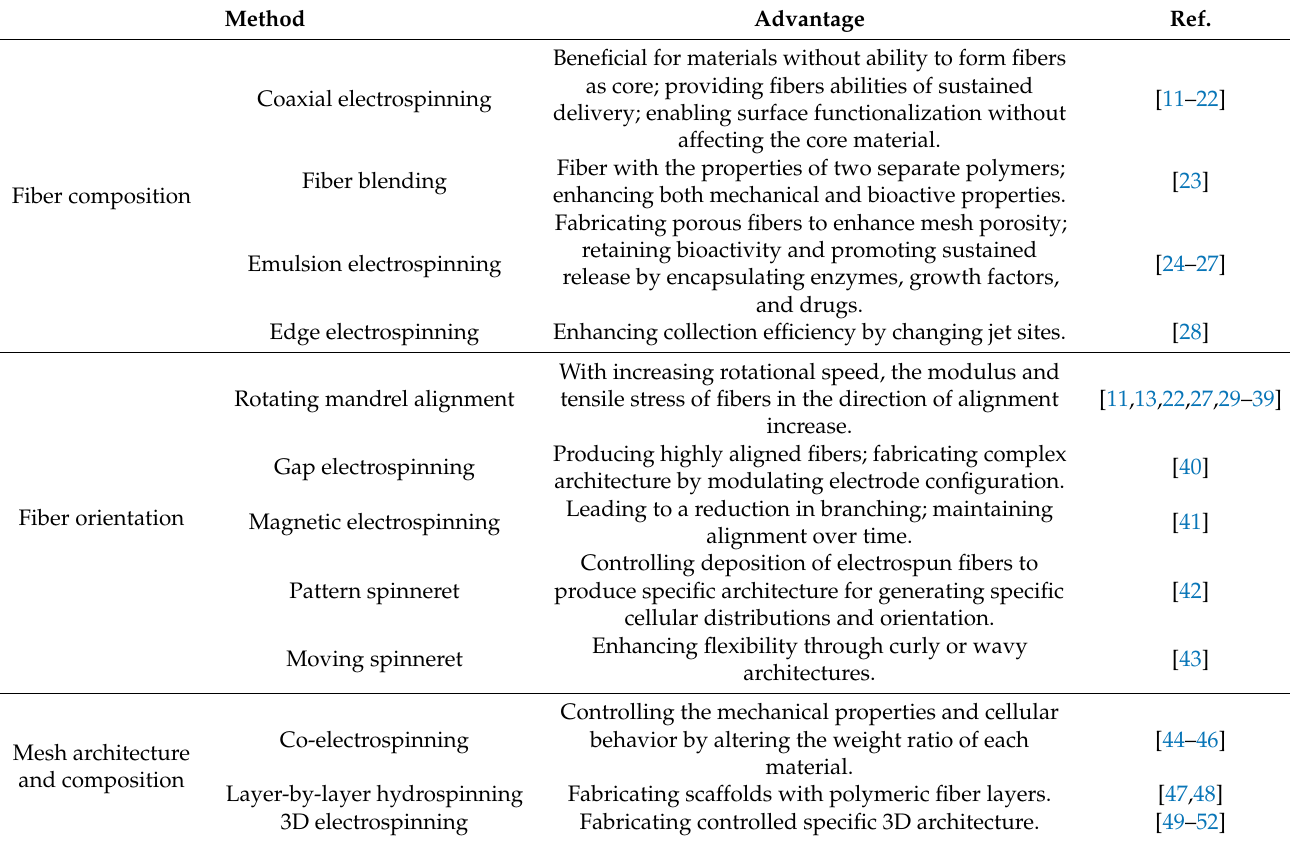
Table 1. Examples of electrospinning